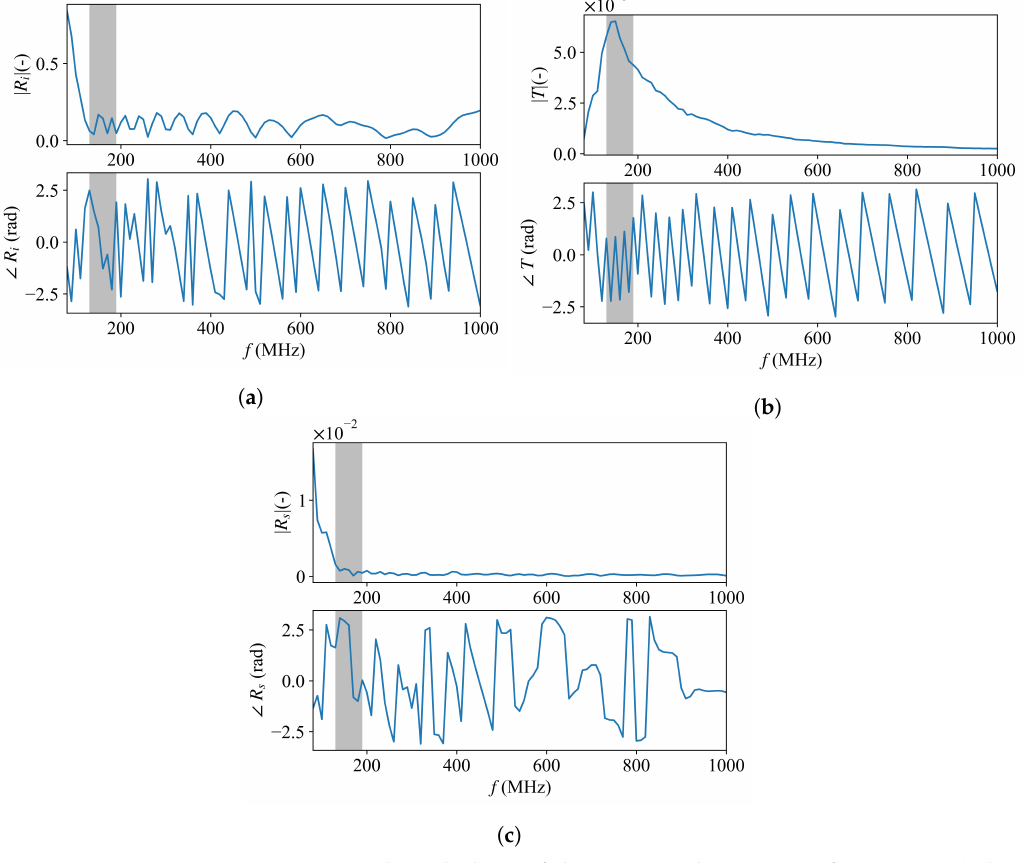
Figure 7. Magnitude and phase of the antenna characteristic functions. ( a ) the return loss R i , ( b ) transmitting-receiving response T and ( c ) feedback loss R s . The grey bar indicates the frequency range 130–190 MHz used for the field